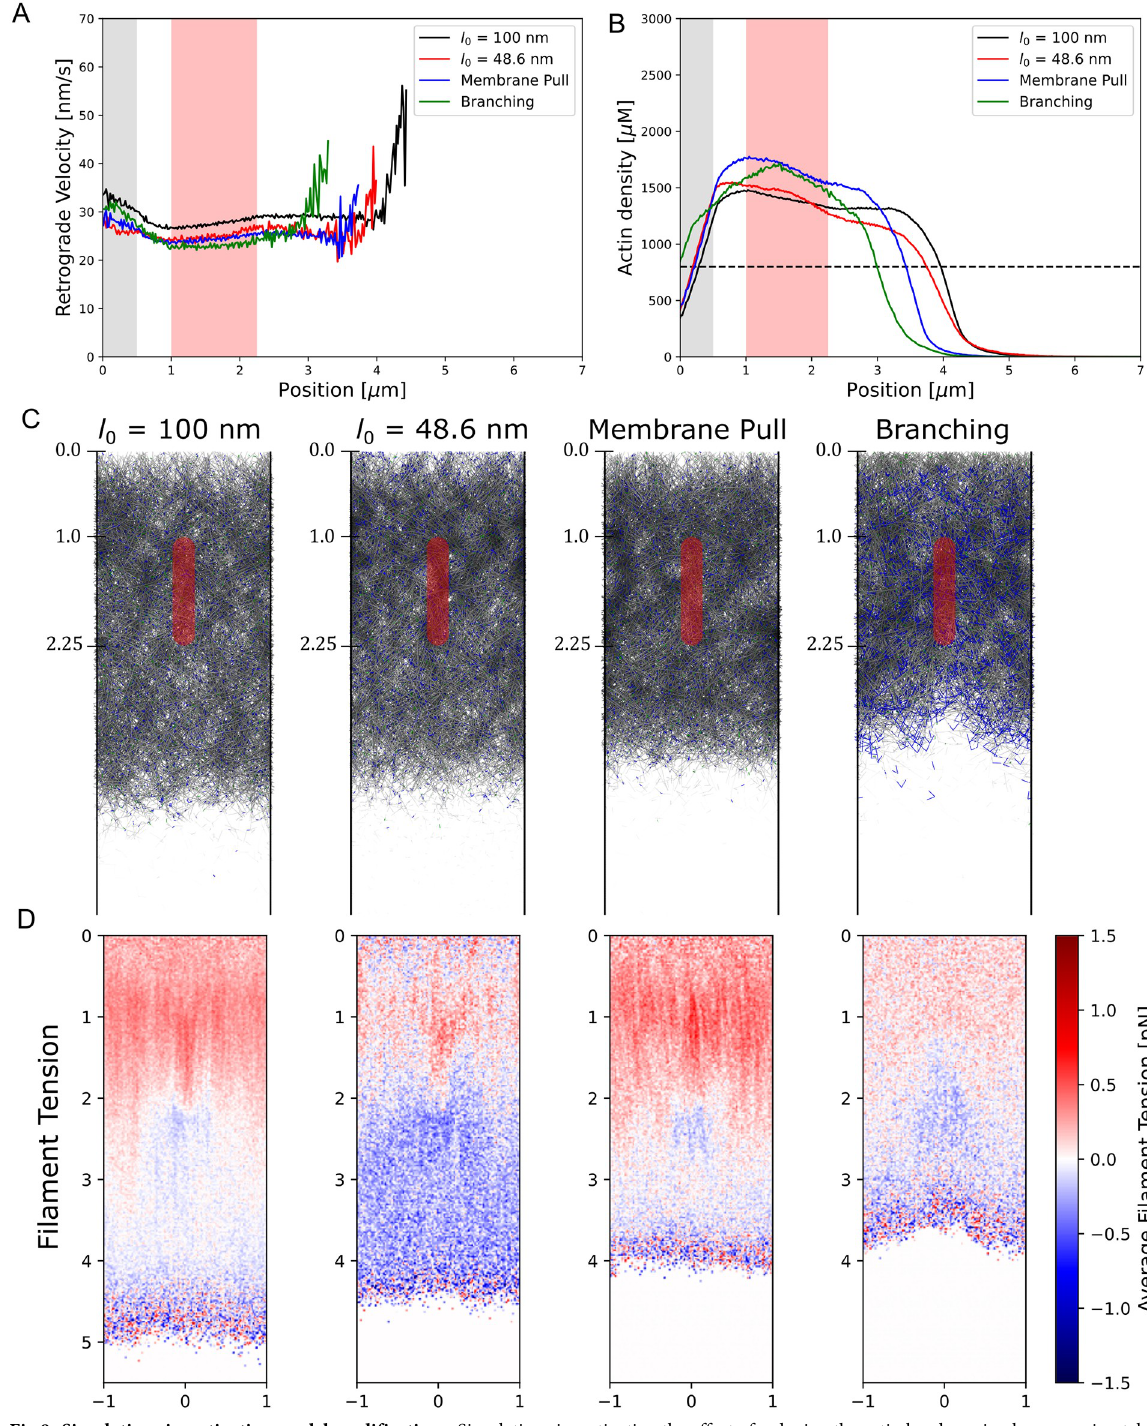
Fig 8. Simulations investigating model modifications. Simulations investigating the effect of reducing the actin bead spacing by approximately half, exerting motor forces only on actin beads within the bottom tenth of the simulation box, and implementing branches instead of permanent crosslinkers to represent the Arp2/3 complex. Simulations were run with κ FA = 100, focal adhesion starting at y = 1 μm , and, except for the membrane pull simulations, the pull uniform mode. (A) Retrograde flow plot as a function of distance from the leading edge for the three modified simulations show qualitative similarities to the reference simulations at l 0 = 100 nm . Grey region indicates the region over which filaments are added while the red region indicates the focal adhesion position (B) Actin density as a function of distance from the leading edge